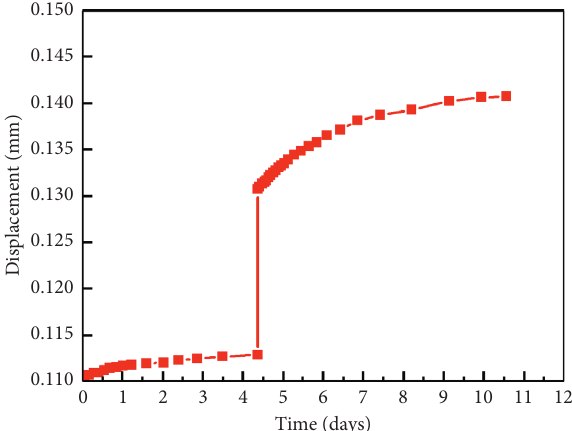
Figure 6: Stable circumferential stress under inner